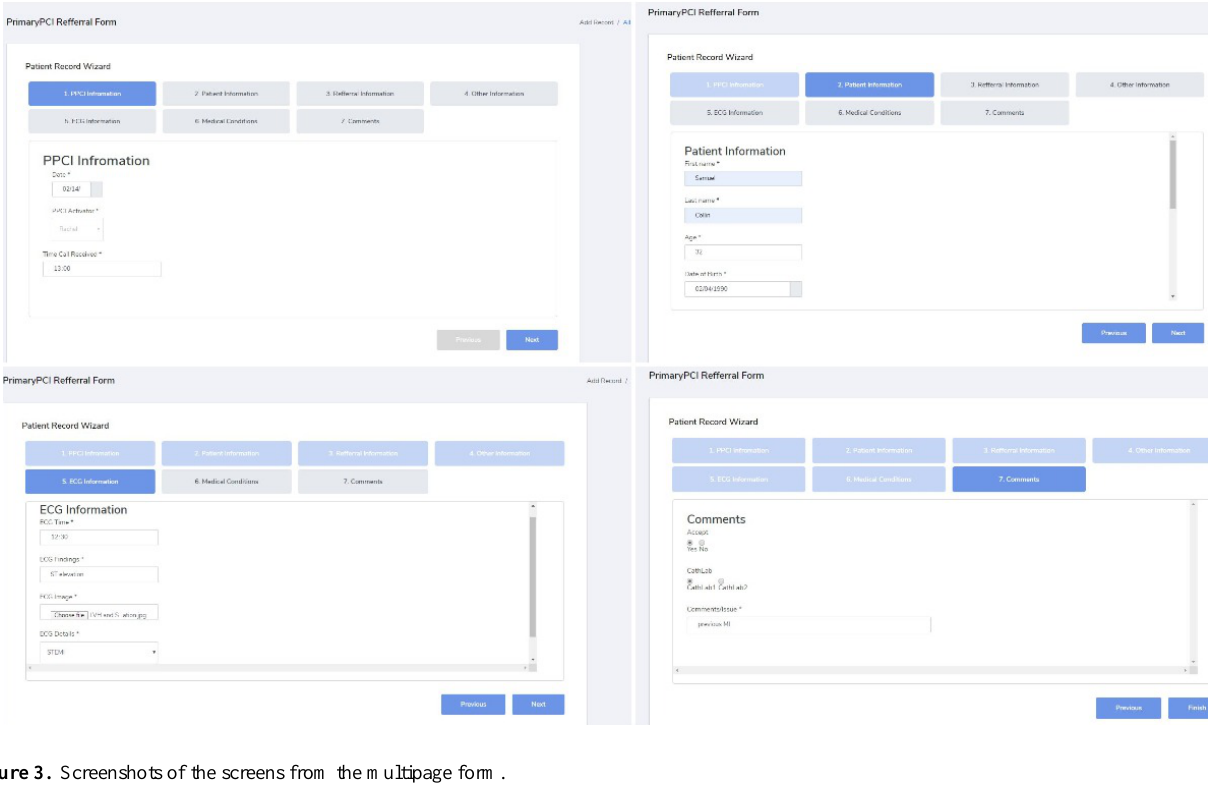
Figure 2. Screenshots of a part of the single-page form.